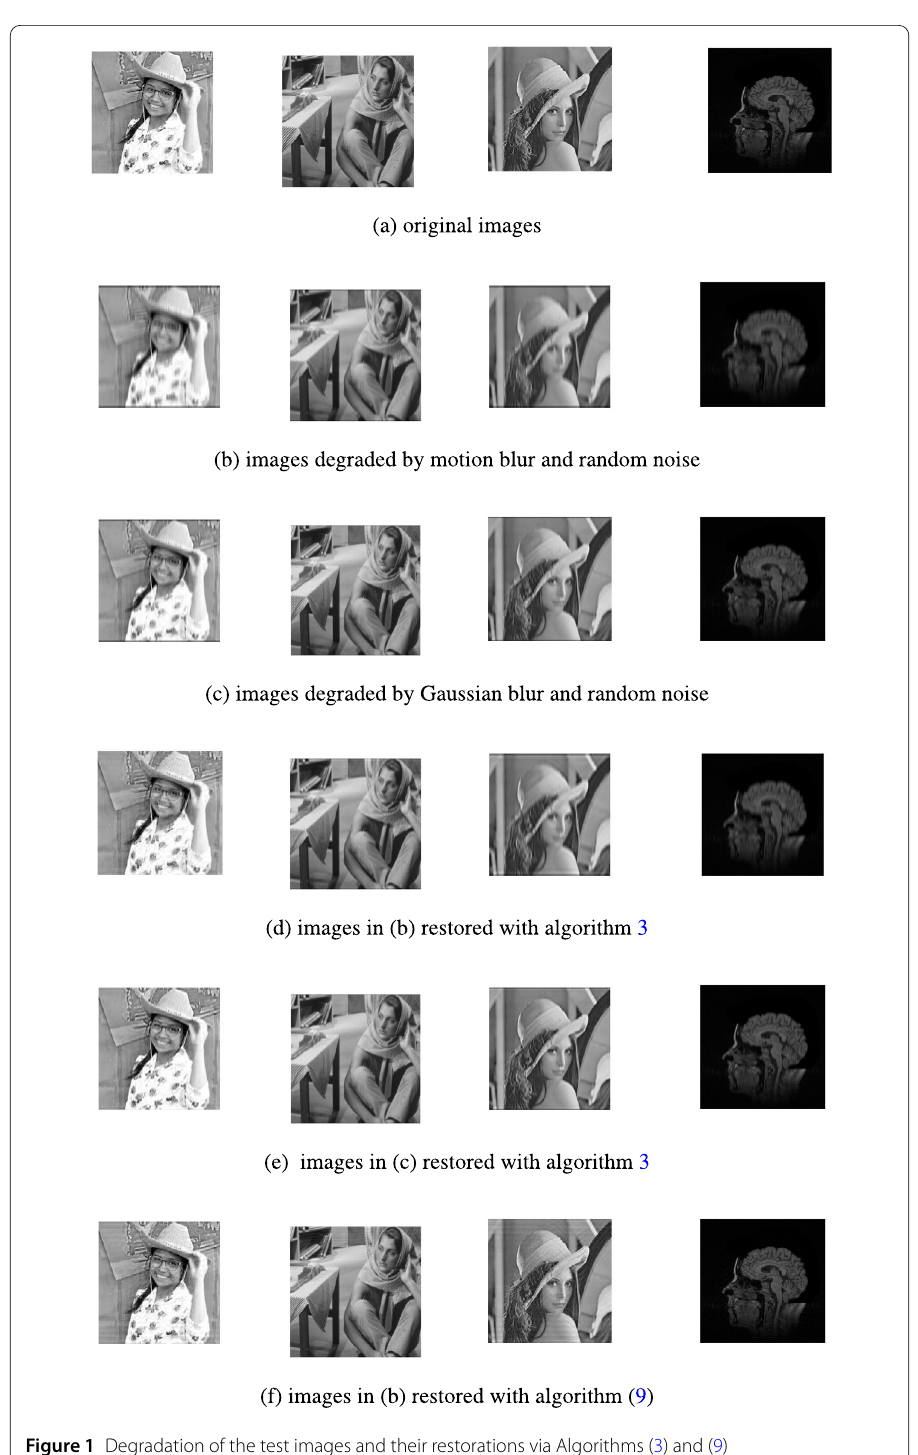
the algorithm. The SNR is defined as